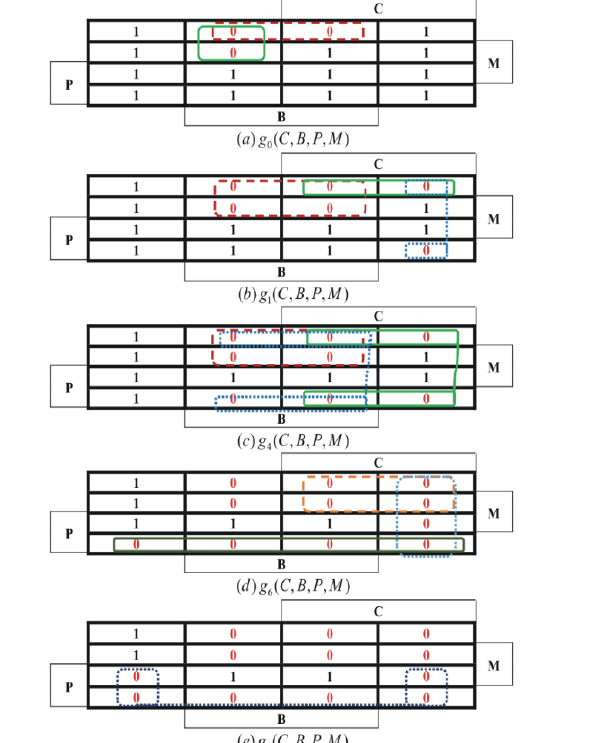
Fig. 8. Karnaugh-map representations for distinct Boolean functions obtained by dichotomization of the pseudo-Boolean function in Fig. 1 for various